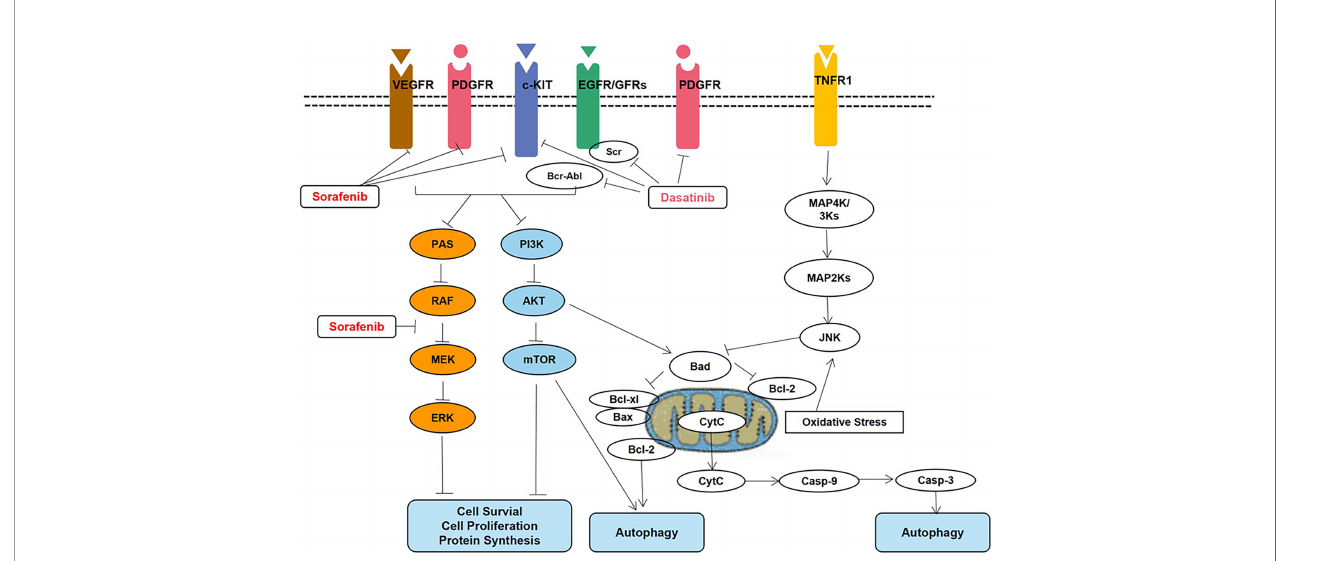
FIGURE 5 | Key signal transduction pathways involved in dasatinib- and sorafenib-induced toxicity in cardiomyocytes. AKT, AKT8 virus oncogene cellular homolog; BAD, Bcl2-associated death promoter; BAX, Bcl2-associated X protein; Bcl-2, B-cell lymphoma 2 protein; Bcl-xl, B-cell lymphoma extra-large protein; Bcr-Abl, fusion protein encoded by the Philadelphia chromosome; Casp-3, caspase-3; Casp-9, caspase-9; c-KIT, stem cell growth factor receptor; Cyt, C cytochrome c; EGFR, epidermal growth factor receptor; ERK, extracellular signal regulated kinase; JNK, Jun N-terminal kinase; MAPK, mitogen activated protein kinase; MEK, MAPK/ERK kinase; mTOR, mammalian target of rapamycin; PDGFR, platelet derived growth factor receptor; PI3K, phosphoinositide 3 kinase; RAF, rapidly accelerated fi brosarcoma kinase protein; RAS, prototypical member of the Ras superfamily of proteins (belonging to the small GTPase group of proteins); Src Rous, sarcoma oncogene cellular homolog tyrosine kinase protein; TNFR1, tumor necrosis factor receptor 1; VEGFR, vascular endothelial growth factor